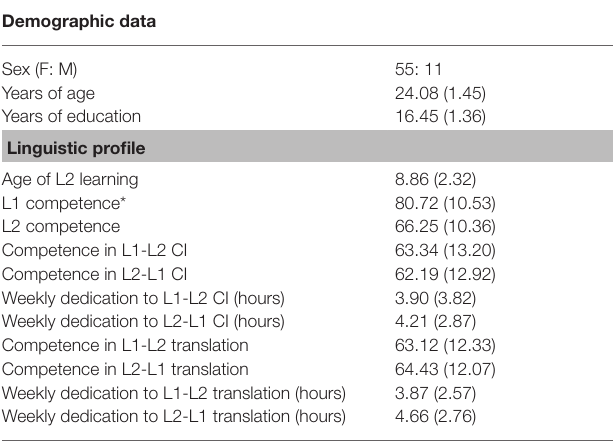
TABLE 3 | The enhanced CI quality protocol.